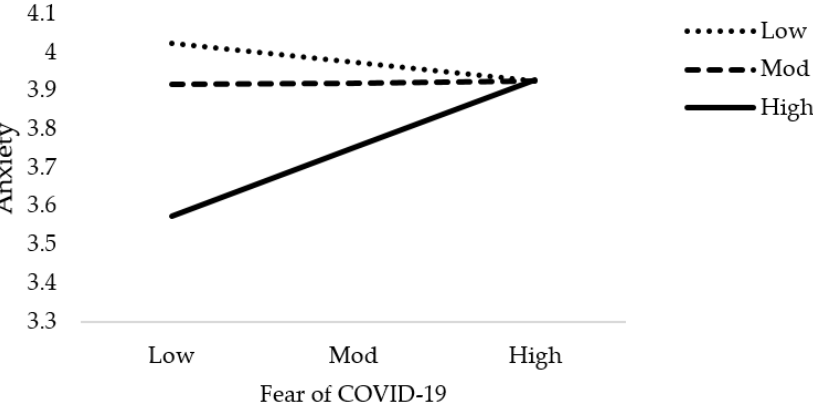
Figure 4. Interactive effect of fear of COVID-19 and social support on psychological distress4. Discussion.